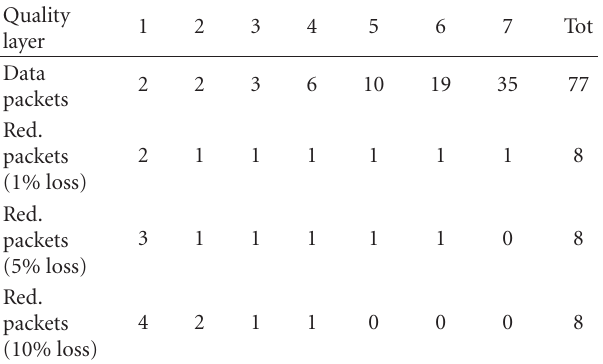
balance redundancy between geometry and texture data.